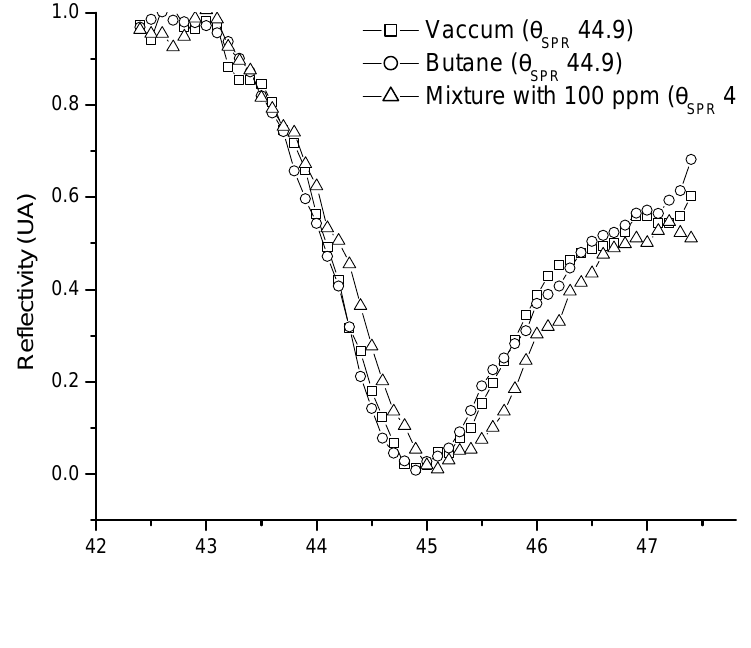
Figure 2. SPR spectra showing the response of the sensing element to 100 ppm(V) of n-dodecane in butane gas